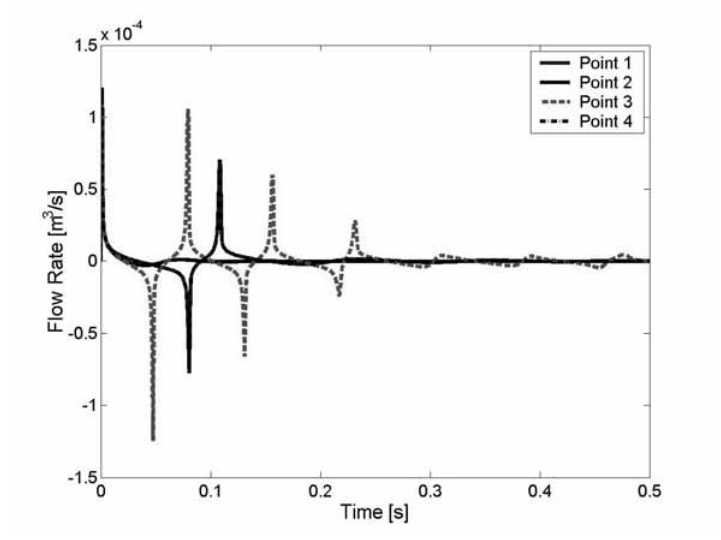
Fig. 33. Optimized decoupler flow rate transient response.